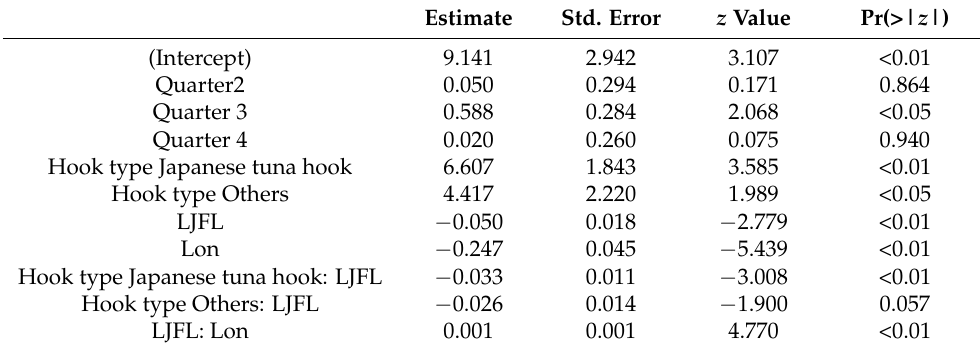
Table 3. The parameter estimation and significance of the model after adding the interaction term for studying the at-haulback mortality of swordfish ( Xiphias gladius ) in the Indian Ocean. Estimate Std. Error z Value Pr(>| z |) (Intercept)